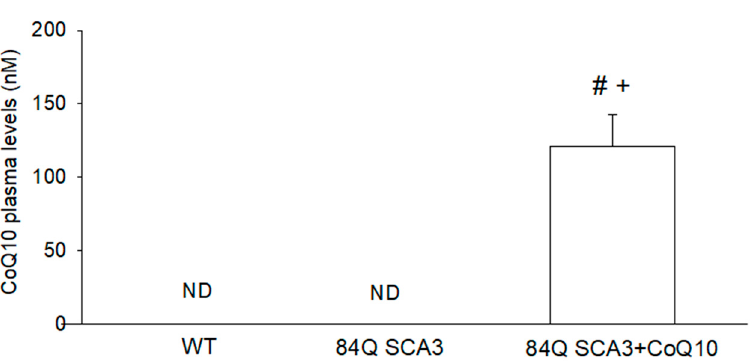
Figure 1. Effects of CoQ10 on plasma concentration in 84Q SCA3 mice. At the age of 16 months, plasma levels of CoQ10 in WT, 84Q SCA3 and CoQ10-treated 84Q SCA3 mice were measured by HPLC. Data are presented as the mean ± SD. # p < 0.05 indicates the 84Q SCA3 + CoQ10 group compare to the 84Q SCA3 group. + p < 0.05 indicates the 84Q SCA3 + CoQ10 group compared to the WT group. WT, wild-type controls; 84Q SCA3, chow diet of vehicle; 84Q SCA3 + CoQ10, CoQ10 supplementation. ND, not